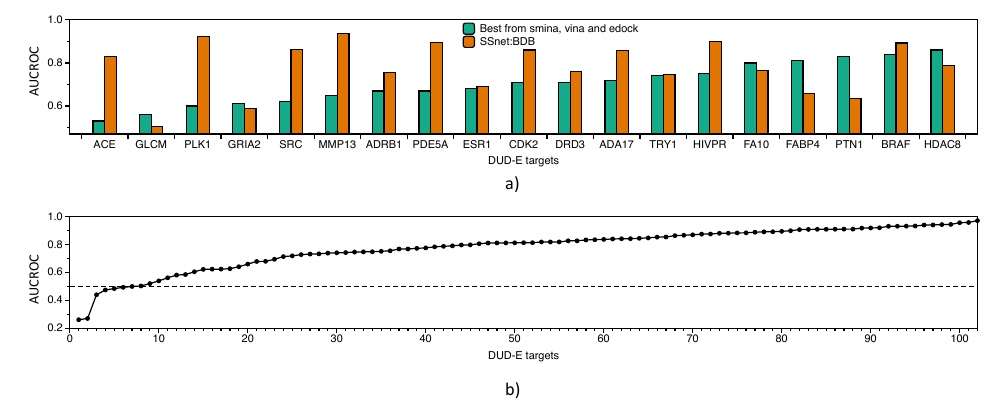
Figure 6. Independent test set DUD-E dataset for BDB model. All targets with more than 75% similarity in DUD-E dataset were removed from BDB model. ( a ) AUCROC comparison on DUD-E targets over best performer from vina, smina, or edock; ( b ) AUCROC comparison with vina for all DUD-E targets.